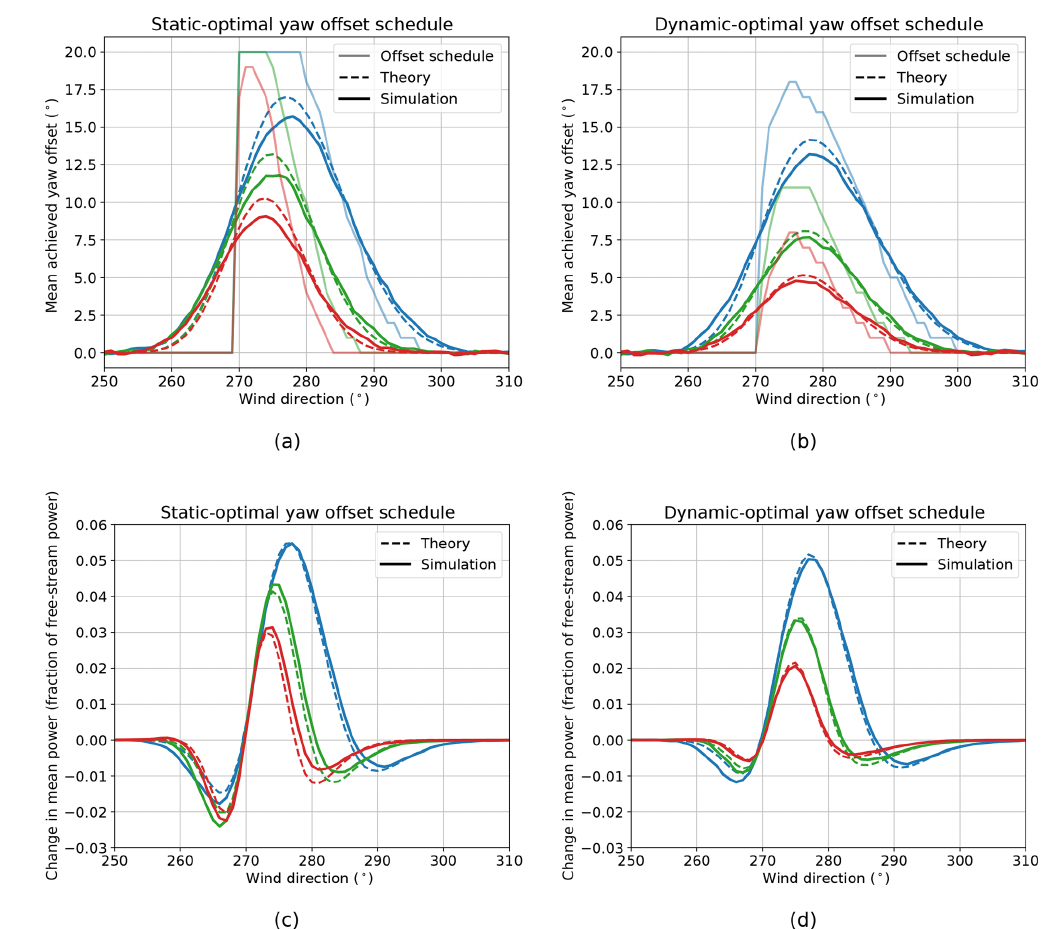
Figure 12. Mean achieved yaw offsets using offset schedules optimized for (a) static and (b) dynamic wind directions as well as change in mean power produced by the turbine pair from wake steering using offset schedules optimized for (c) static and (d) dynamic wind directions as a function of low-frequency wind direction for turbine spacings of 3 D (blue), 5 D (green), and 7 D (red). Achieved theoretical and simulation-based offsets and power gains are shown for dynamic wind directions, along with the yaw offset schedules. A turbulence intensity of 10% is used in the FLORIS model.